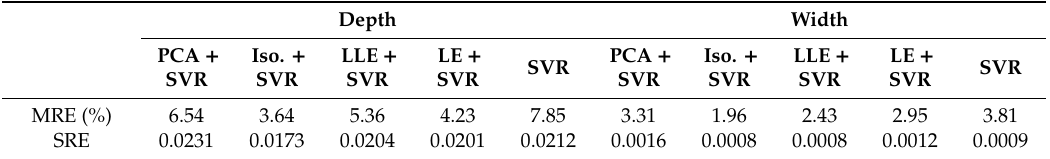
Table 2. The MREs (mean relative errors) of defect depth and width estimation. PCA stands for principal component analysis, LLE represents local linear embedding and LE is Laplacian